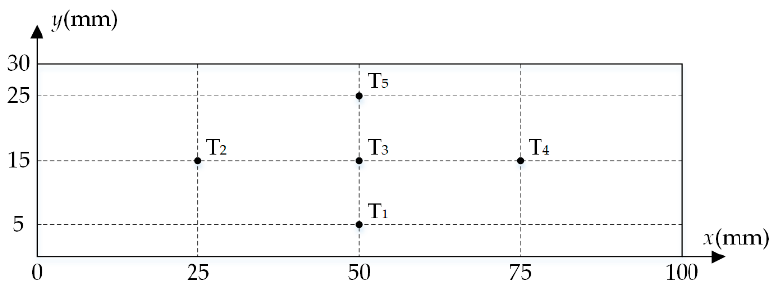
Figure 4. The location of thermocouples inside the specimen.